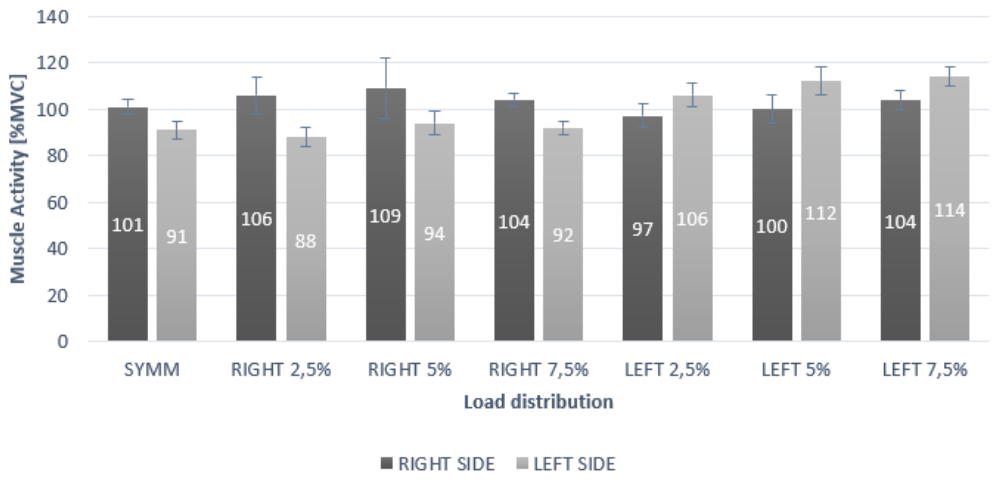
Figure 1. Muscle activity of anterior deltoid under different loading positions.